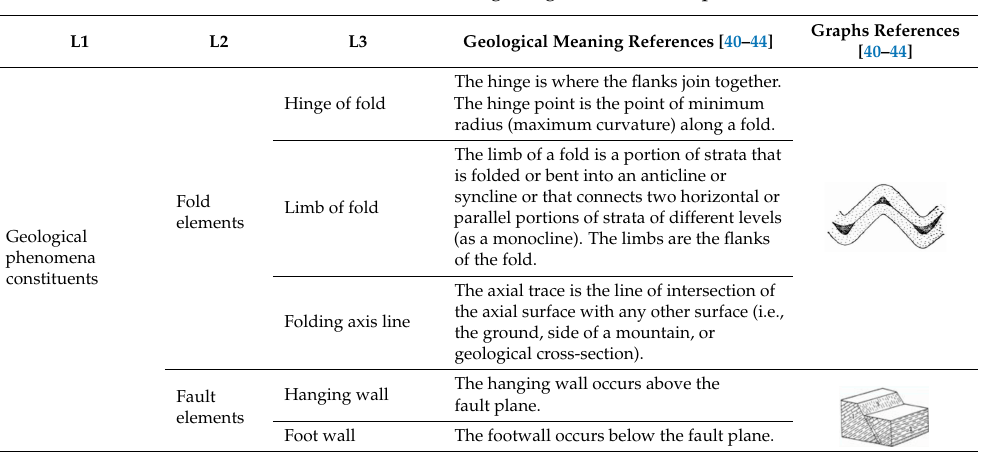
Table 1. Classification of geological phenomenon in regional geological structures.